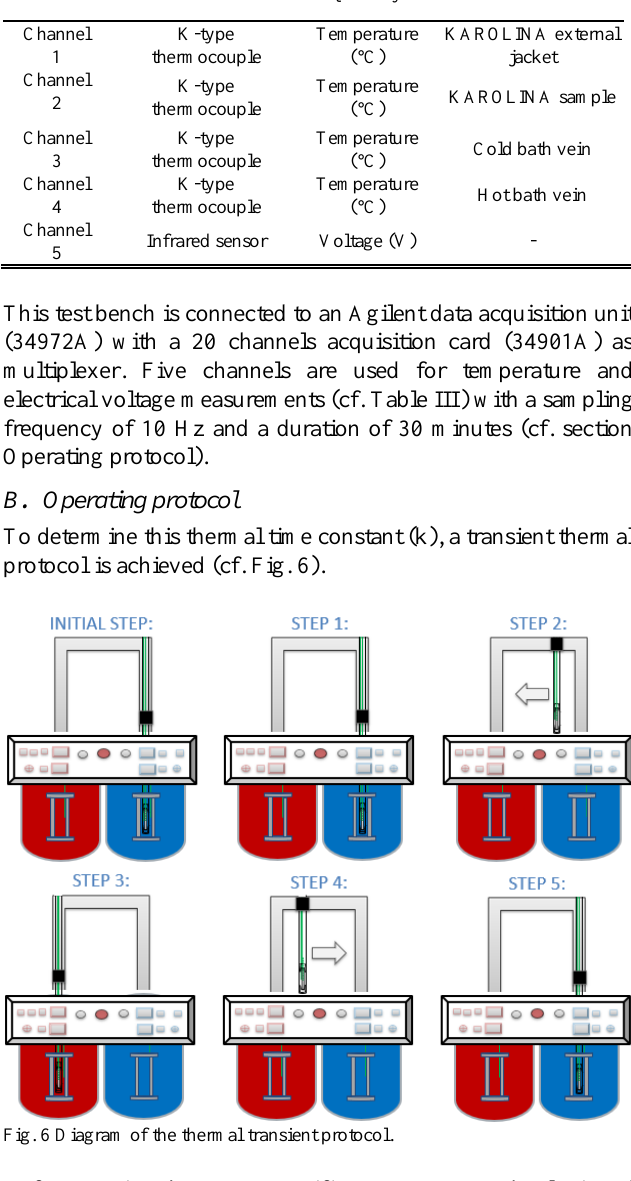
TABLE III: A CQUISITION CHANNELS OF BERTRAN BENCH Sensors